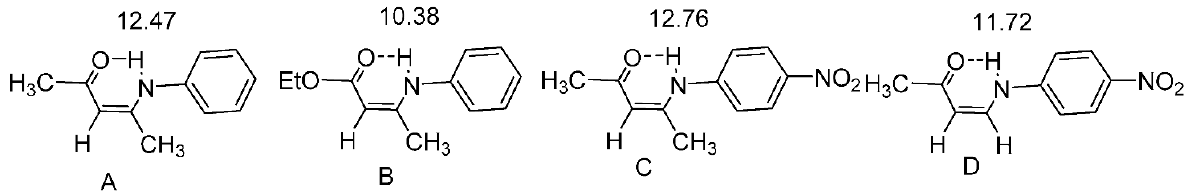
Figure 5. Comparison of different acceptors ( A , B ) and demonstration of steric compression ( C , D ). The numbers are NH chemical shifts in ppm. A and B from [15,26]. For the corresponding N ‐ methyl derivatives, the chemical shifts are 10.90 ppm and 8.55 ppm. ( C ) is from [12] and ( D ) from [27].